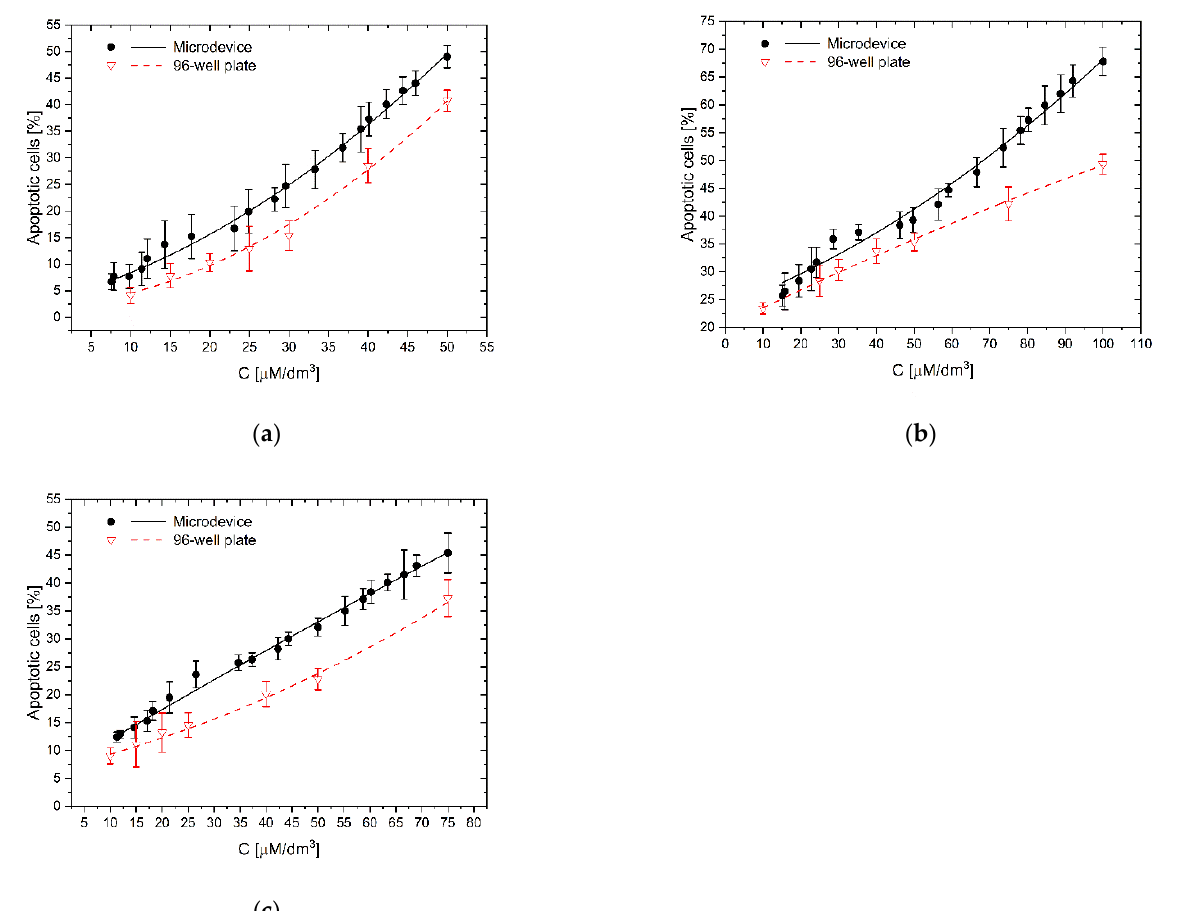
Figure 8. The effect of the substance concentration gradient and cellular interactions on apoptosis of LoVo cells: ( a ) curcumin; ( b ) trans -resveratrol; ( c ) wogonin: C–the concentration of a tested substance. Comparison of results of investigations in a gradient microsystem and a traditional 96-well culture plate.